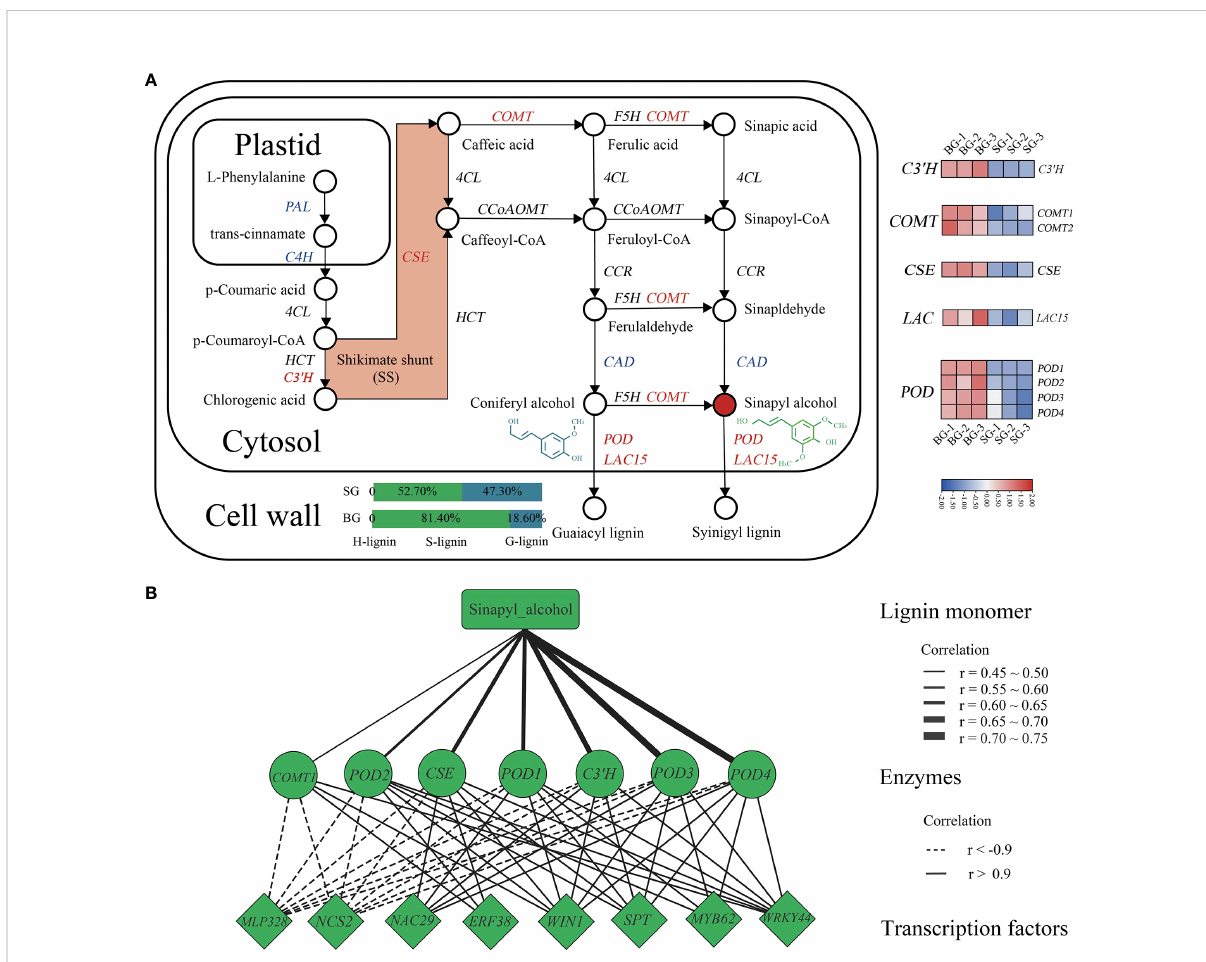
FIGURE 4 Analysis of the lignin biosynthetic pathways of BG and SG capsules. (A) Map showing the lignin biosynthetic pathway for patterns of DEGs. Expression of lignin-related genes is shown by a heatmap using log10 (FPKM); red represents upregulation, and blue represents downregulation. (B) Coexpression network of lignin biosynthesis end products, upregulated DEGs, and transcription